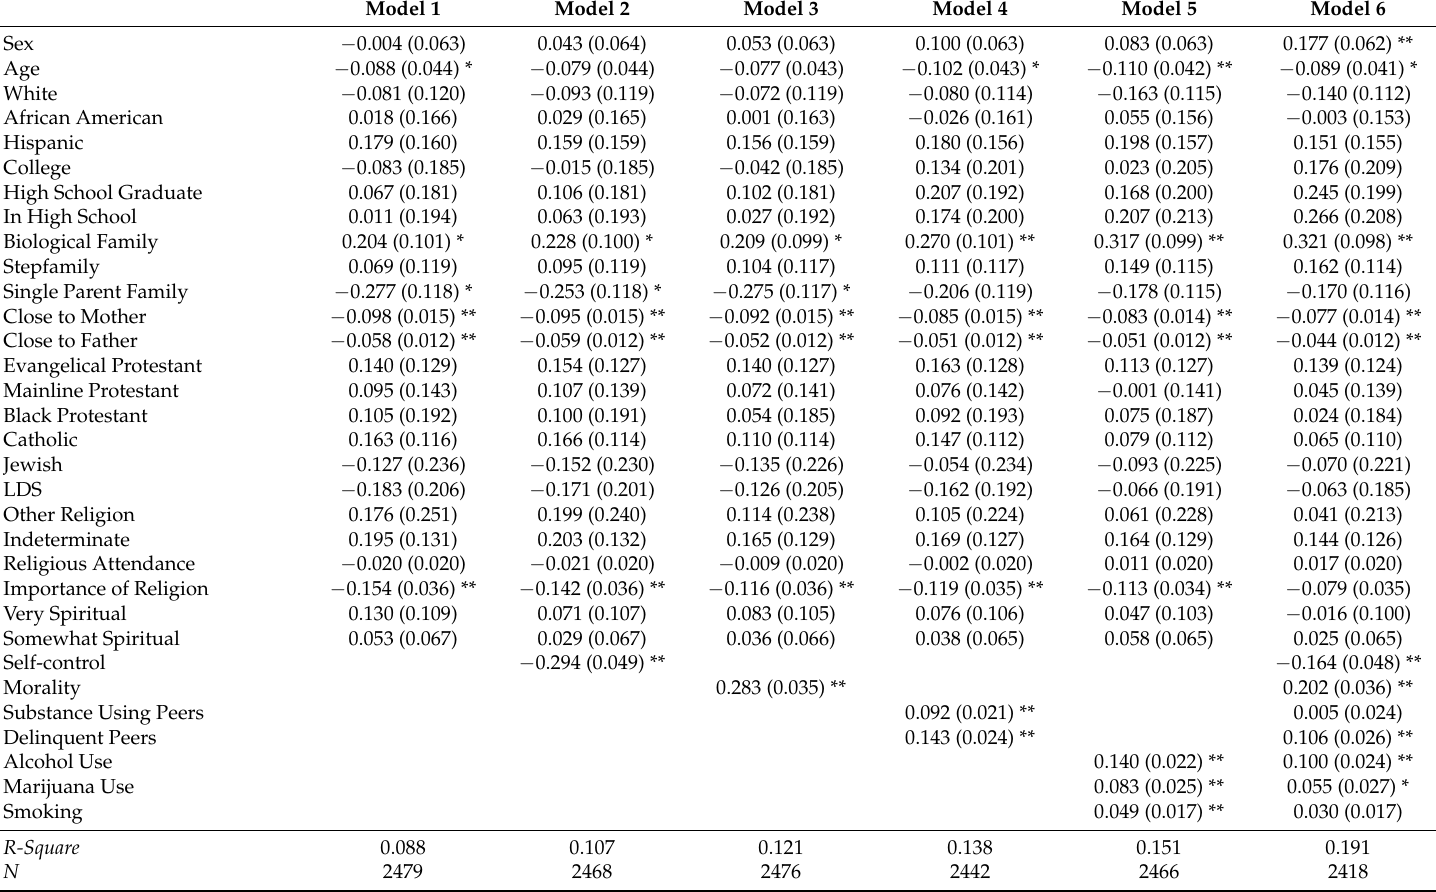
Table 3. OLS Regression of Lying to Parents on Religion and Mediators (Standard